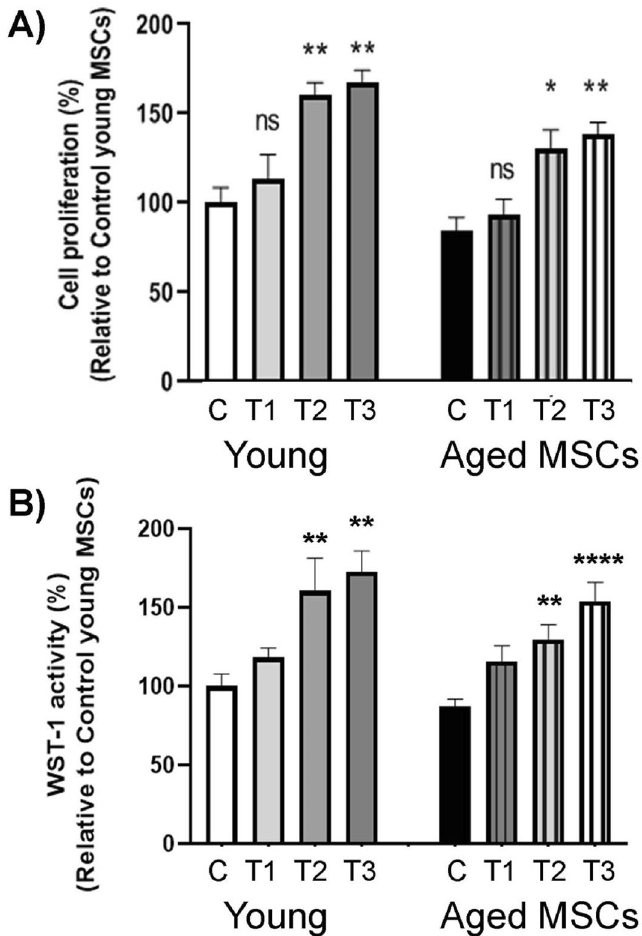
Figure 6. Effects of single and multiple doses of PBM on proliferation of young and aged MSCs: Both young and aged MSCs underwent a PBM treatment at 3 J/cm 2 for 1, 2 or 3 days in a row. The control group did not receive any treatment. ( A ) On day 7, the cells from both the control and the experimental groups were harvested to determine the cell viability and total number of cells in each group using a trypan blue exclusion assay. Shown is the percentage of cell proliferation in each group relative to the untreated young MSC control group, with significant differences indicated by asterisk signs. * p < 0.05; ** p < 0.01. ( B ) On day 7, metabolic activity was measured using WST-1 assays. Shown is the percentage of cell proliferation in each group relative to the untreated young MSC control group with significant differences indicated by asterisk signs. ** p < 0.01; **** p <